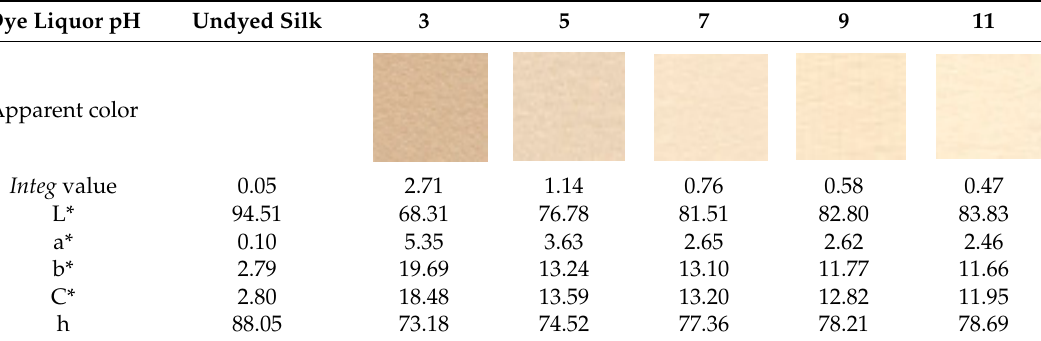
Figure 5. Effect of pH value on Integ value of dyed silk fabrics. Table 1. The color parameters of dyed silk fabrics with tea polyphenols.